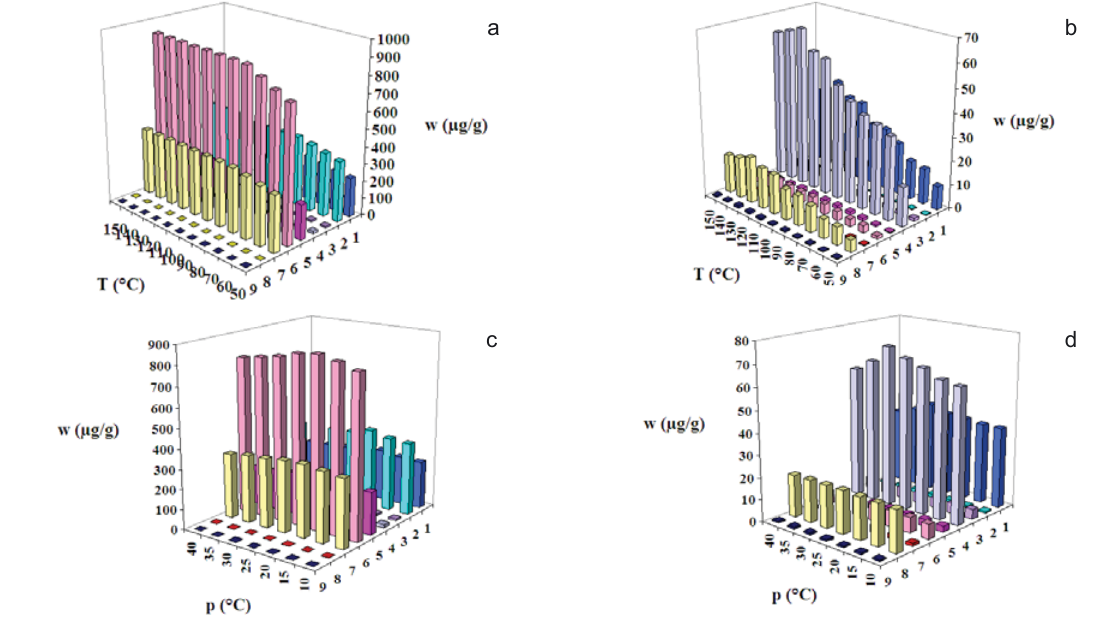
Figure 4. Optimization of temperature (a, b) and pressure (c, d) in needles P. pungens and leaves J. regia L